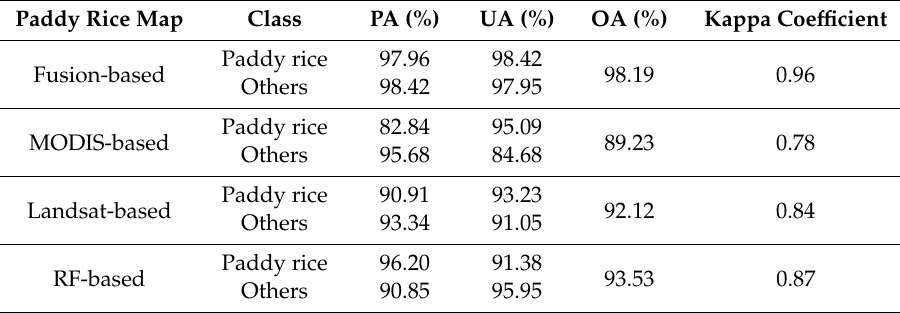
Table 4. The confusion matrixes between the four maps and areas of interest (AOIs).